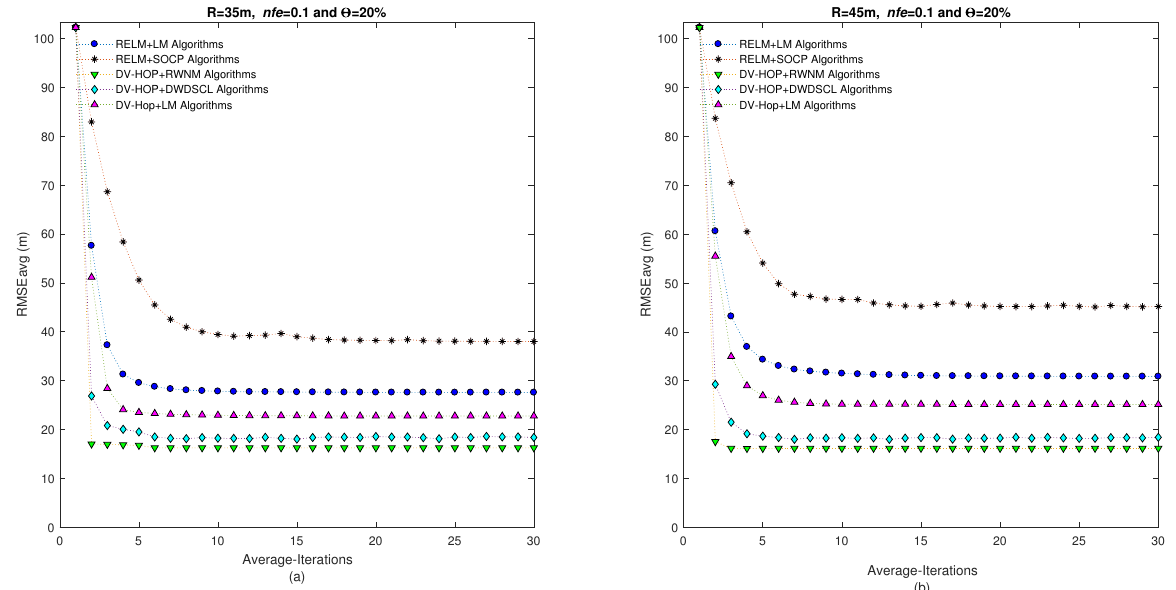
Figure 12. RMSEavg vs. Iterations of algorithms using Θ = 20% and nfe = 0.1 considering the average of 10 independent anisotropic networks. ( a ) Corresponds to R = 35 m and ( b ) R = 45